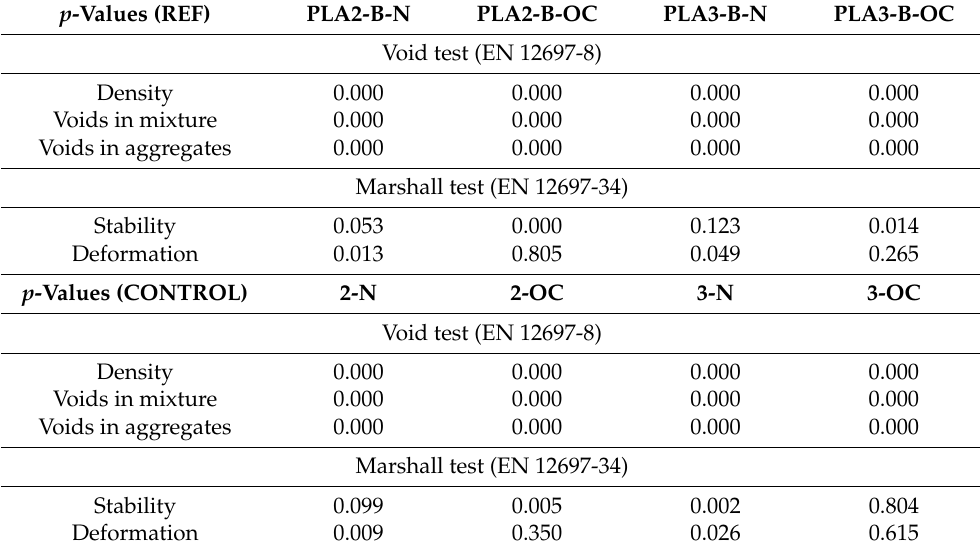
Table 7. p -values for volumetric properties and Marshall